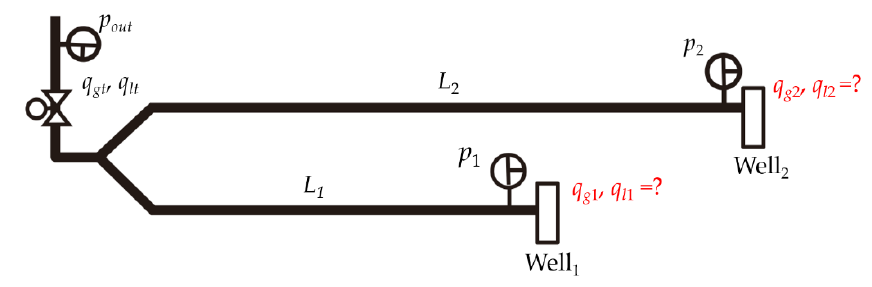
Figure 2. Simplified model of an MWMS with two pipelines.